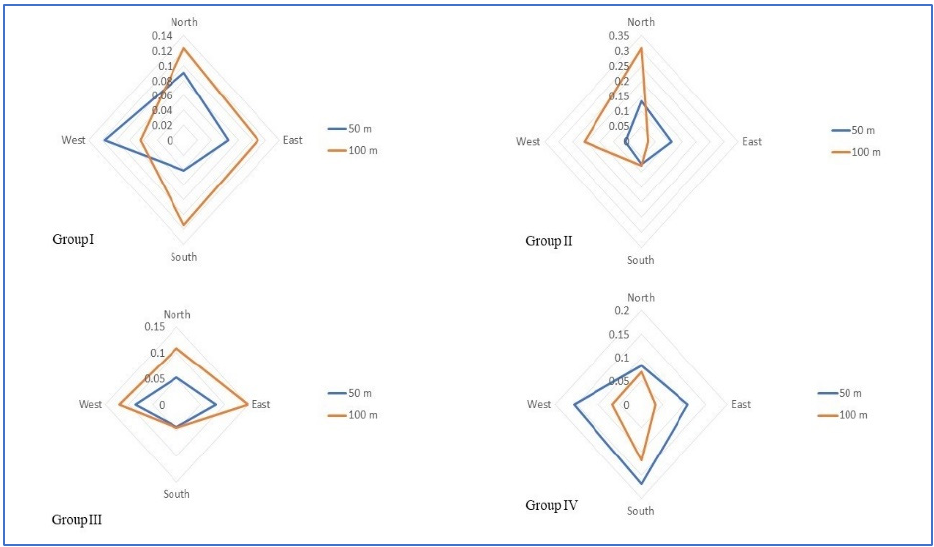
Figure 5. Radar chart showing power density distribution around cell phone towers among different study groups.